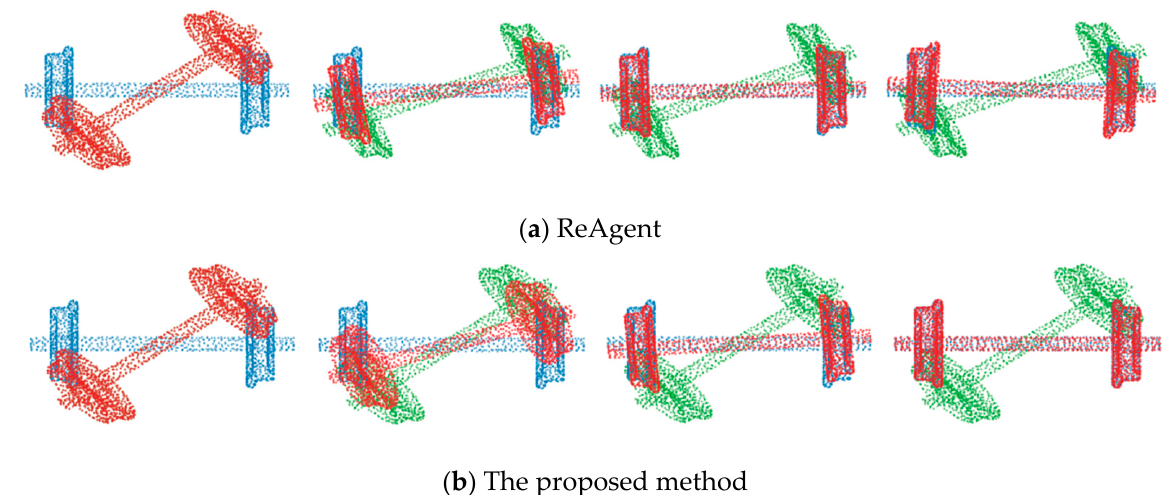
8 Figure 5. Performance Comparisons under Different Noise Levels. 4.3. Experiment on ScanobjectNN and Other Real-World Data Experiments have also been conducted based on the ScanObjectNN dataset [37], which is collected from the depth sensor as the real data. The point clouds are segmented objects in ScanObjectNN, including 15 categories and 581 models in total, and 2048 points for each point cloud. Furthermore, an additional category containing train components was manually col- lected (see [38]). Figure 6 shows 8 component point clouds such as traction rods, bolts, and wheelsets. They also have 2048 points with some noise after resampling. So, there are 16 categories and 589 point cloud models in the evaluated dataset. Figure 6. The train component point cloud. Figure 7 shows the process of registration in train component wheelsets; the source point cloud (red) is transformed into the target point cloud (blue) step by step. The green point cloud represents the initial position of the source point cloud. Figure 7a demon- strates the results based on the ReAgent registration, and Figure 7b shows the results